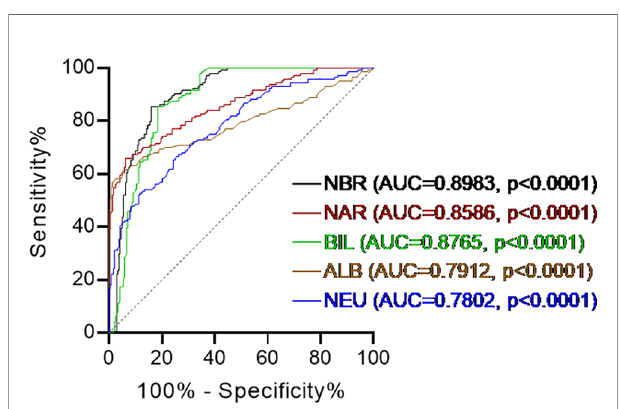
FIGURE 1 | Receiver operating characteristics (ROC) curve analysis. Discriminate abilities of serum levels of albumin (ALB), total bilirubin (BIL), blood neutrophil percentage (NEU) and the neutrophil-to-albumin ratio (NAR), neutrophil-to-bilirubin ratio (NBR) in patients with Crohn ’ s disease (CD) and healthy controls. Receiver operating characteristics (ROC) curve analysis was performed. AUC, area under the ROC curve. p < 0.05 was considered signi fi cant.